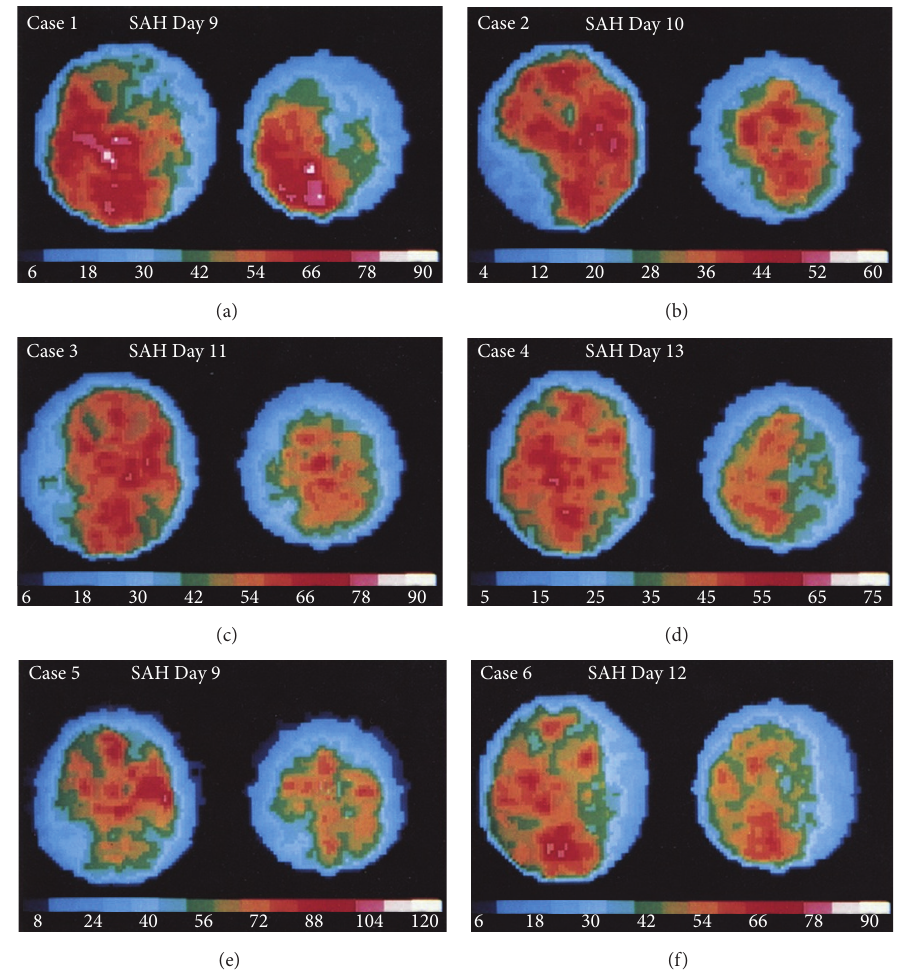
�enon Clearance. Scans show rC�F pattern defects in 6 patients with cerebral vasospasm and associated �IN�. �e �gure is adapted from